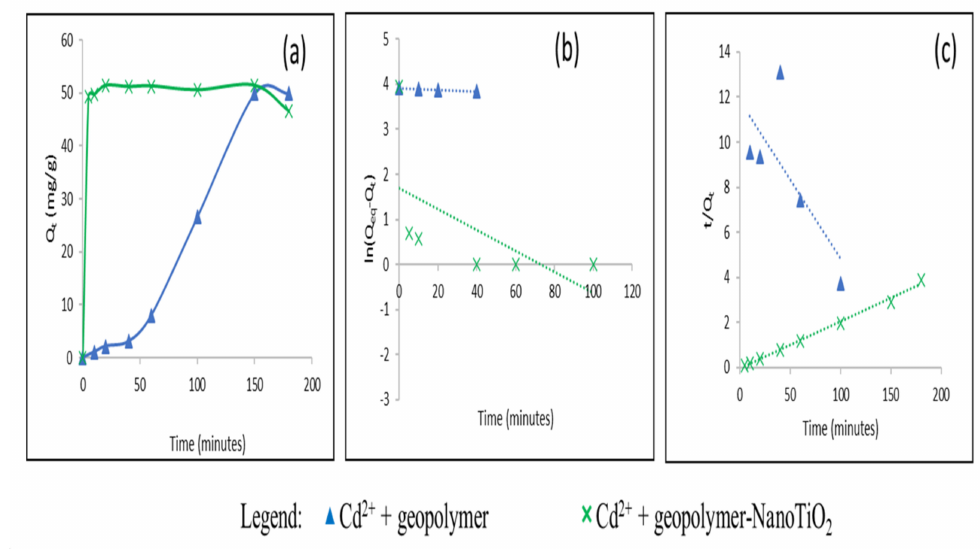
Figure 5. ( a ) Kinetic model of Cd 2+ on geopolymer and geopolymer-NanoTiO 2 composite (volume (15 mL), mass of adsorbent (0.3), pH (6.8), ambient temperature, and stirring speed (250 rpm)), ( b ) Pseudo First Order, ( c ) Pseudo Second Order.